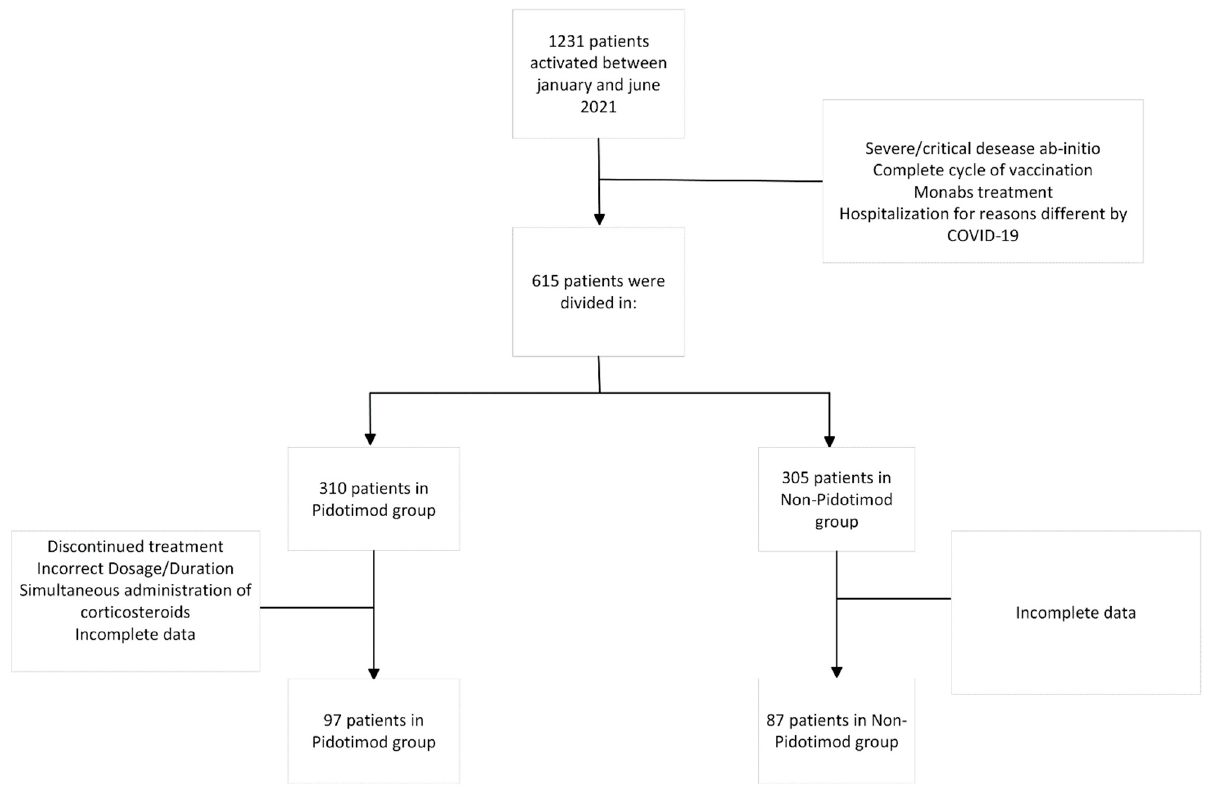
Figure 1. Study enrolment.